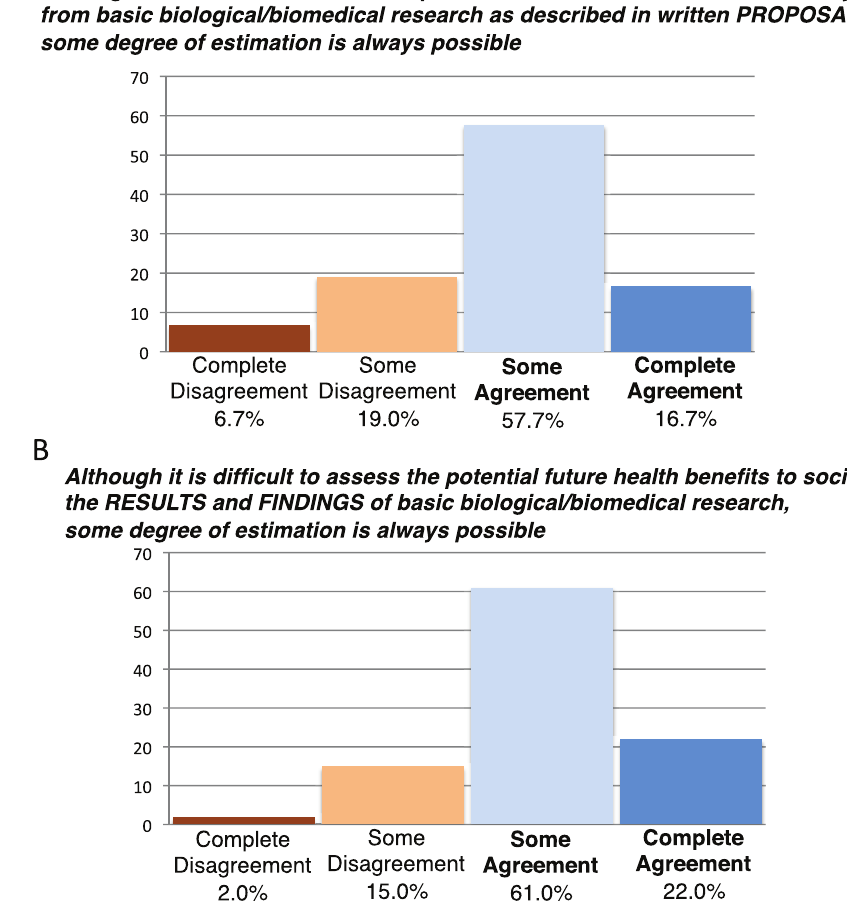
Figure 4. Most scientists think it is possible to estimate future health benefits potential of basic research. ( A ) Graph shows the levels of agreement on the following statement: “Although it is difficult to assess the potential future health benefits to society from basic biological/ biomedical research as described in written PROPOSALS, some degree of estimation is always possible”. 300 scientists answered the question; 4 skipped. ( B ) Graph shows the levels of agreement on the following statement: “Although it is difficult to assess the potential future health benefits to society from the RESULTS and FINDINGS of basic biological/biomedical research, some degree of estimation is always possible” 300 answered the question; 4